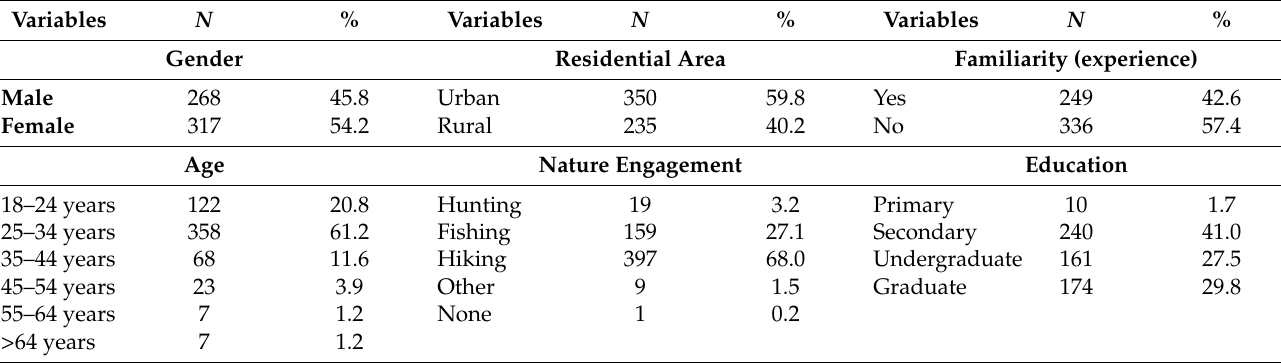
Table 2. Socio-demographic information of the local respondents ( N = 585).